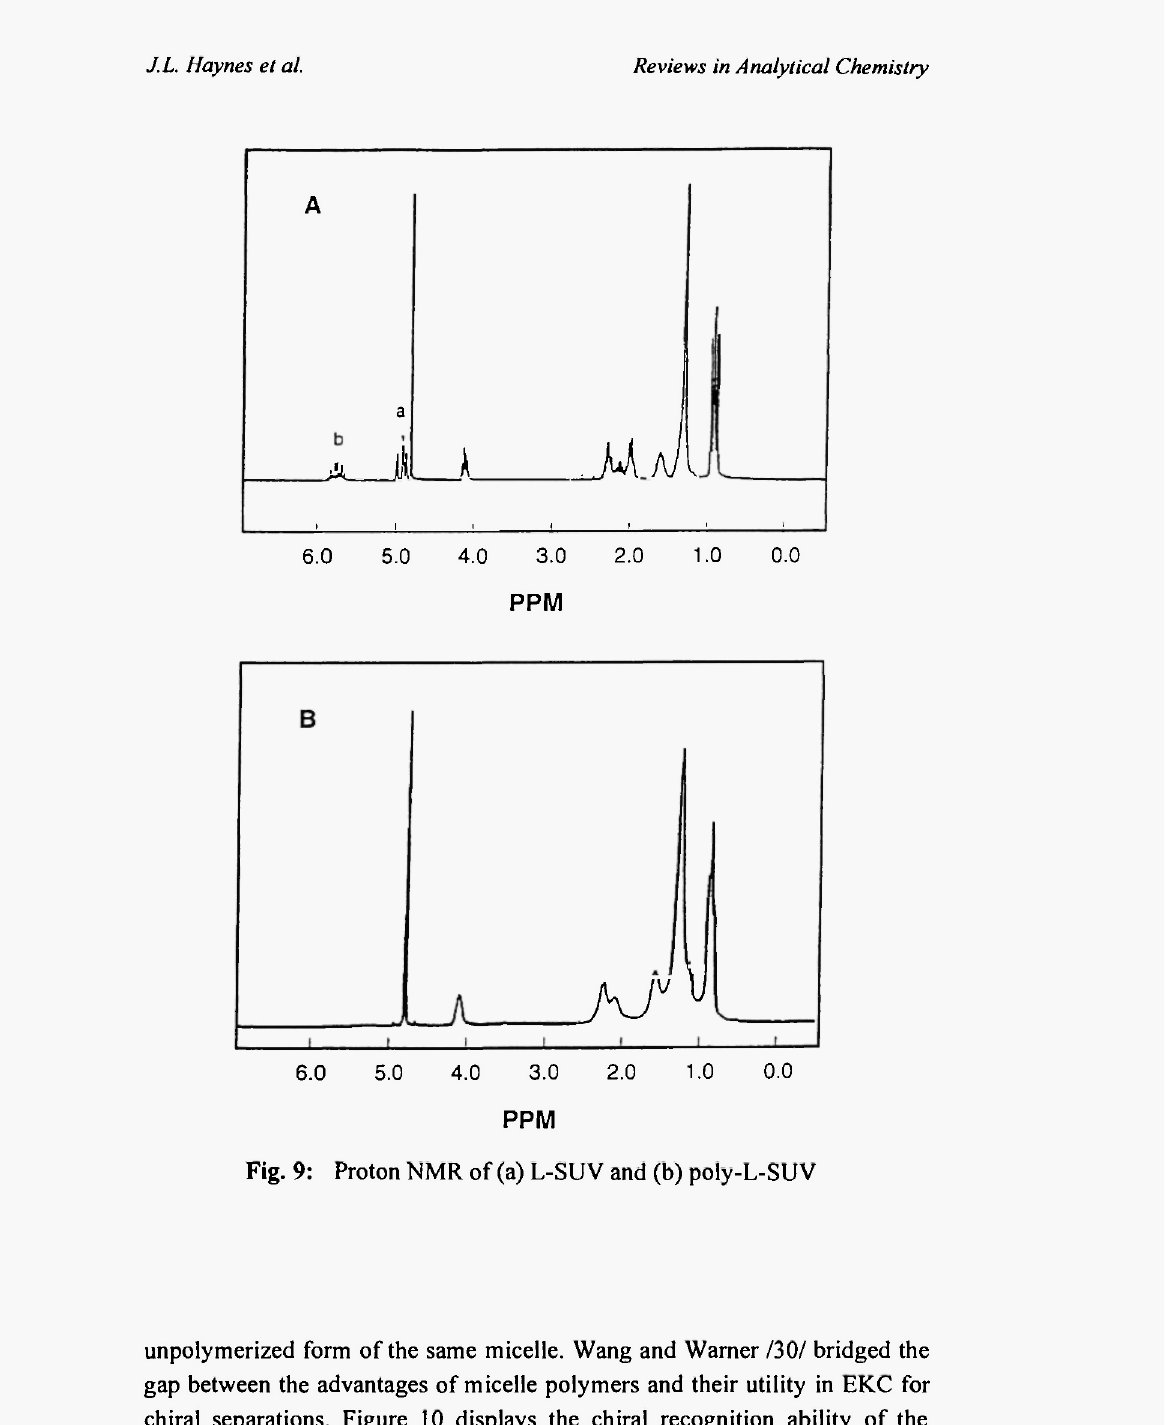
unpolymerized form of the same micelle. Wang and Warner /30/ bridged the gap between the advantages of micelle polymers and their utility in EKC for chiral separations. Figure 10 displays the chiral recognition ability of the micelle polymer poly-L-SUV as compared to that of L-SUV. In Figure 10A,